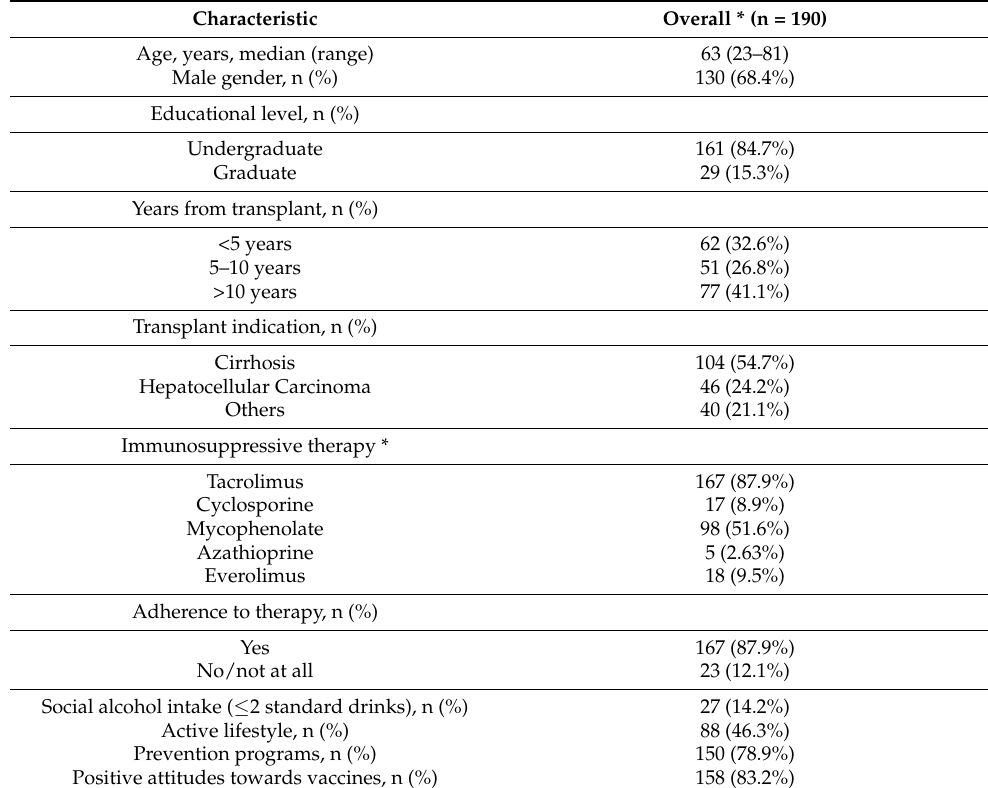
Table 1. Sociodemographic, lifestyle, and clinical characteristics of liver transplant recipients who answered the